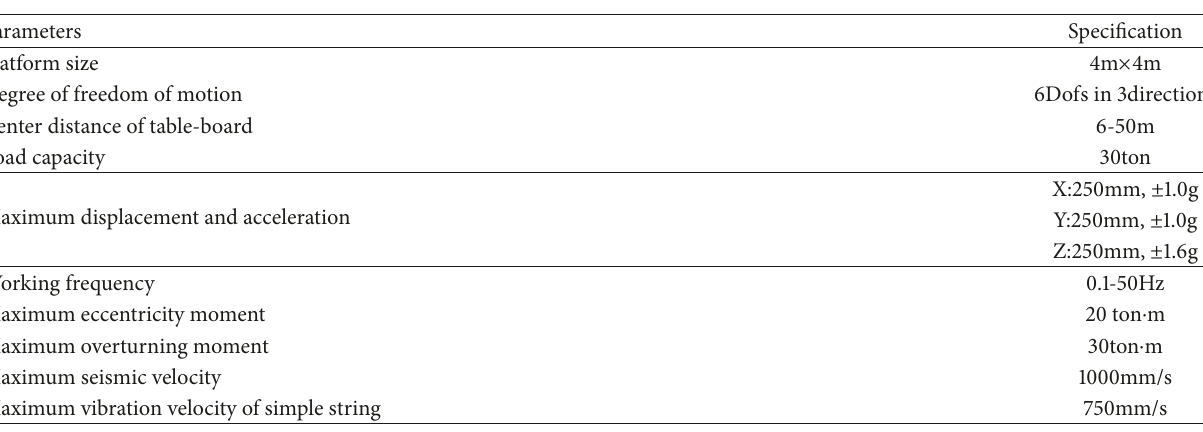
Table 2: Main parameters of shaking